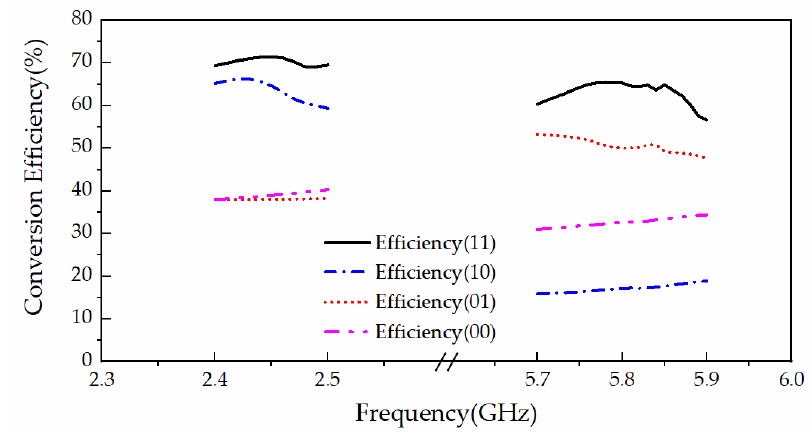
Figure 13. The detailed impact in the four cases on conversion efficiency.